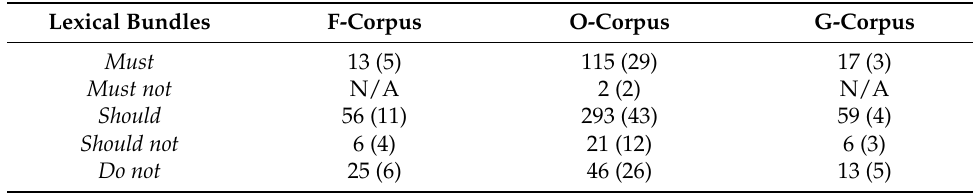
Table 4. Frequency of modal verbs in the FOG corpus, along with range . Lexical